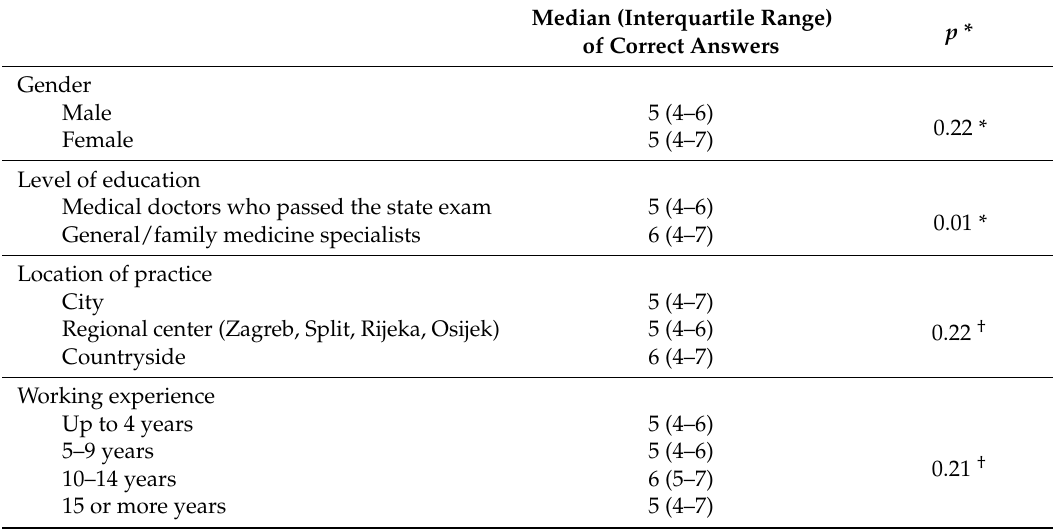
Table 3. Mean values of correct answers according to participant’s